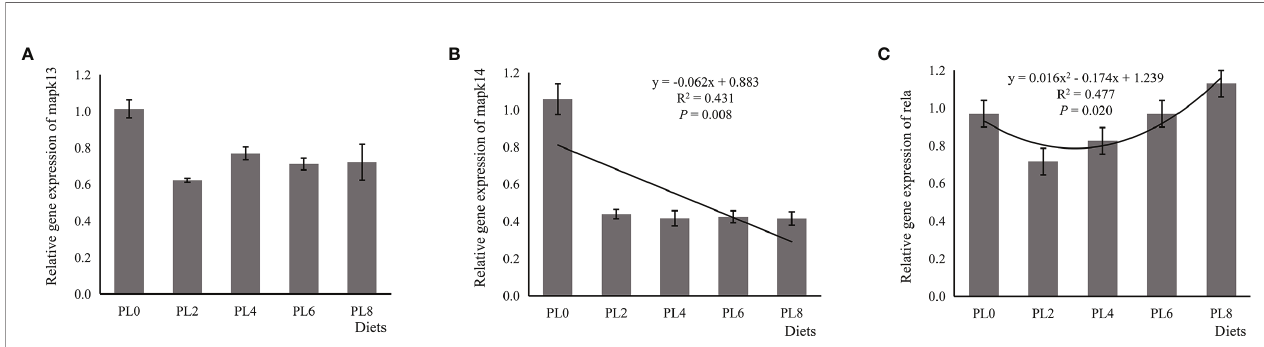
FIGURE 4 | Relative expression of mitogen-activated protein kinase (MAPK) signal pathway related genes, including mapk13 (A) , MAPK14 (B) , and rela (C) , in intestine of larval largemouth bass fed diets with graded levels of phospholipids for 28 days. mapk13 : P linear = 0.202, R 2 linear = 0.122; P quadratic = 0.311, R 2 quadratic = 0.177; mapk14 : P linear = 0.008, R 2 linear = 0.431; P quadratic < 0.001, R 2 quadratic = 0.735; rela : P linear = 0.881, R 2 linear = 0.023; P quadratic = 0.020, R 2 quadratic = 0.477. The “ x ” in the regression equation means the variation of dietary phospholipids content.